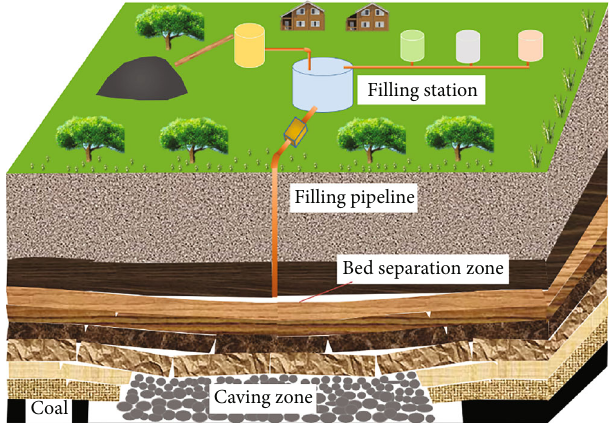
Figure. 1: Schematic diagram of separation